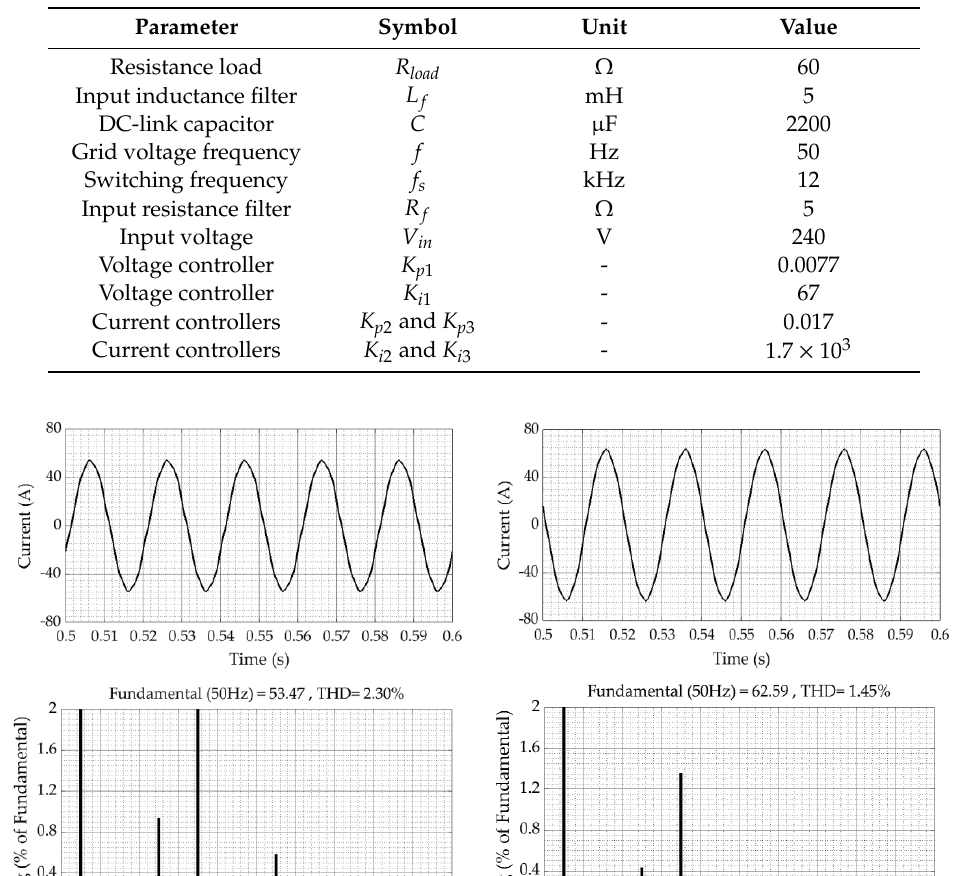
Table 2. Parameter specifications for Level 2 charging.